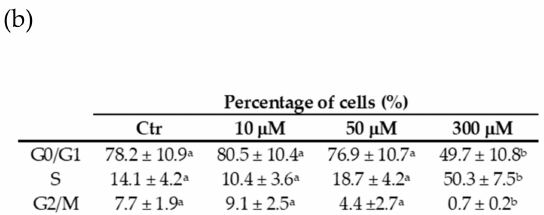
Figure 2. E ff ect of NaHS increasing doses (0, 10, 50, 300 µ M) on the pVW–MSC cell cycle after 24 h of treatment (CTR = DMSO 0.01% v / v ). ( a ) Representative histograms. ( b ) Percentage of cells (mean ± S.D.) of each phase at the di ff erent doses. Results are representative of three independent experiments; di ff erent superscript letters indicate significant di ff erences among groups ( p < 0.05, one-way ANOVA, post hoc Tukey comparison test).